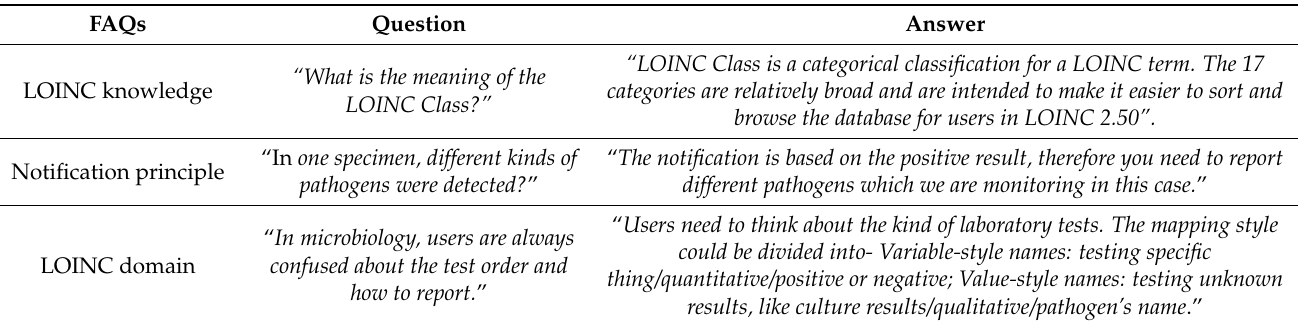
Table 6. Experts’ responses related to